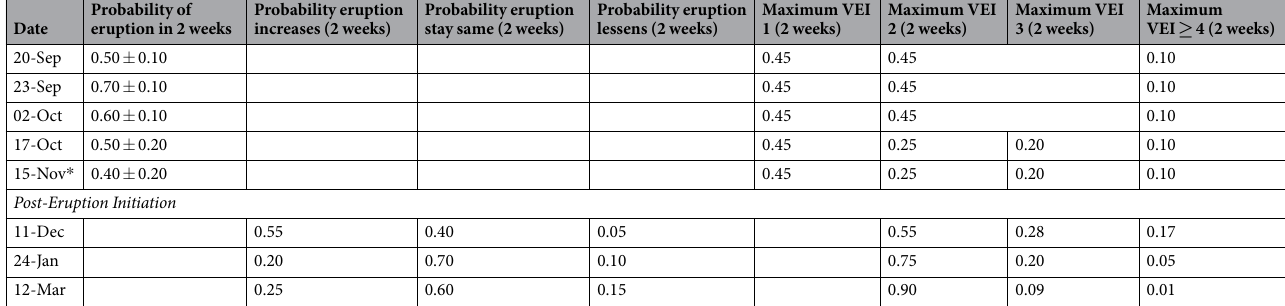
Table 2. Probability-tree exercises to assist eruption forecasting. * In only the 15-Nov event tree, the relative likelihood that eruptions would be phreatic vs. magmatic was added to the tree and estimated at